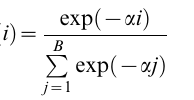
PLoS Computational Biology |